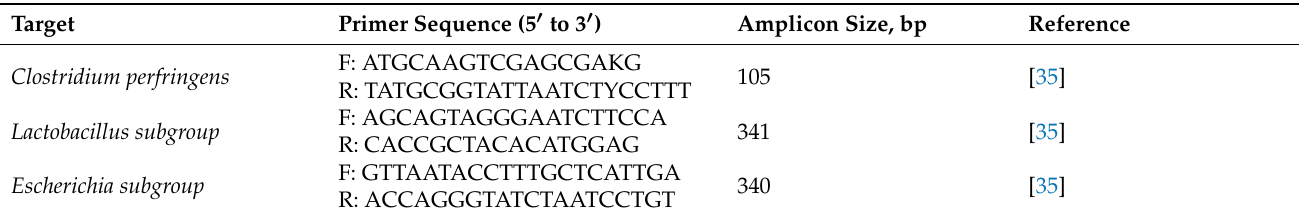
Table 1. qRT-PCR primers used to quantify intestinal